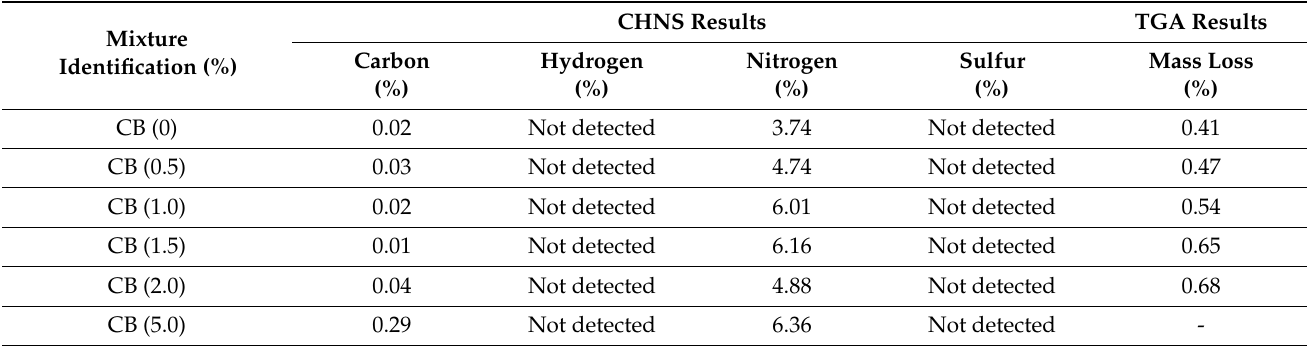
Figure 2. XRD spectra of raw clay soil and FCBs incorporating 0%, 0.5%, 1%, 1.5%, and 2% CBs. Q: Quartz, M: Muscovite, Mi: Mikasite, A: Albite, B: Bismuth oxide, I: Iron chromium oxide. Table 3. Concentration of carbon, hydrogen, nitrogen, and sulfur content and mass loss in bricks incorporating 0%, 0.5%, 1%, 1.5%, 2%, and 5% CBs by